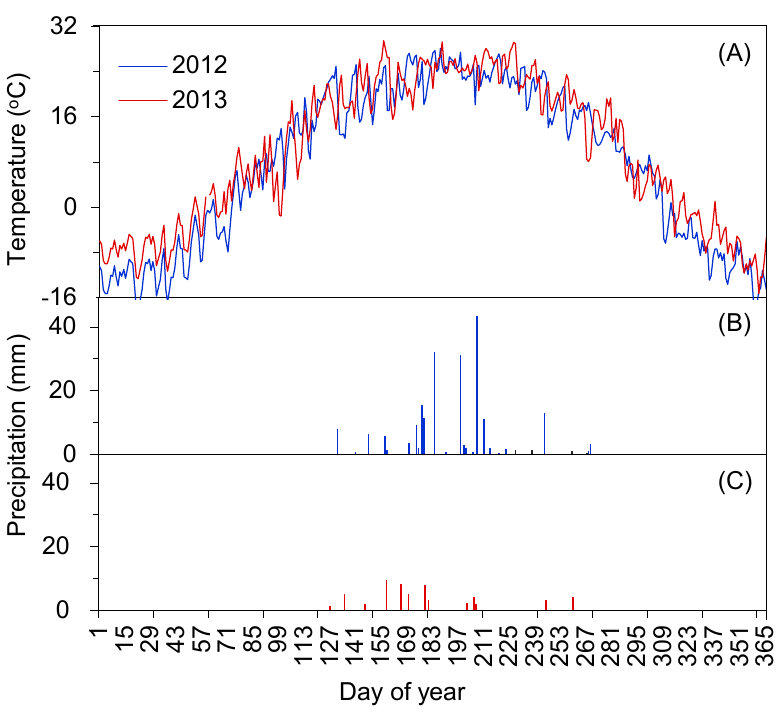
Figure 2. Dynamic changes of daily temperature ( A ), daily precipitation in 2012 ( B ) and daily precipitation in 2013 ( C ). Solid arrows indicate the times of the simulated enhancement of precipitation.